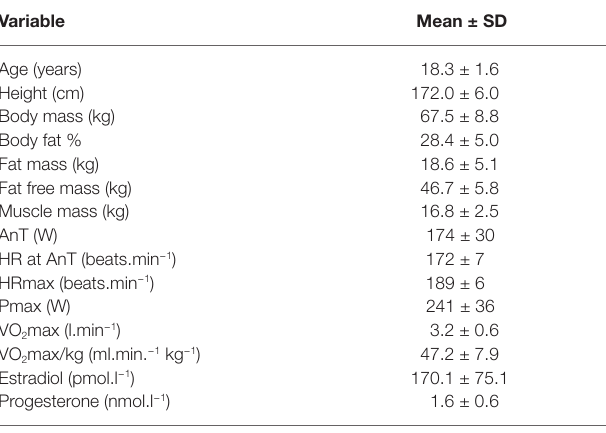
TABLE 1 | Mean (±SD) subject characteristics in female rowers.